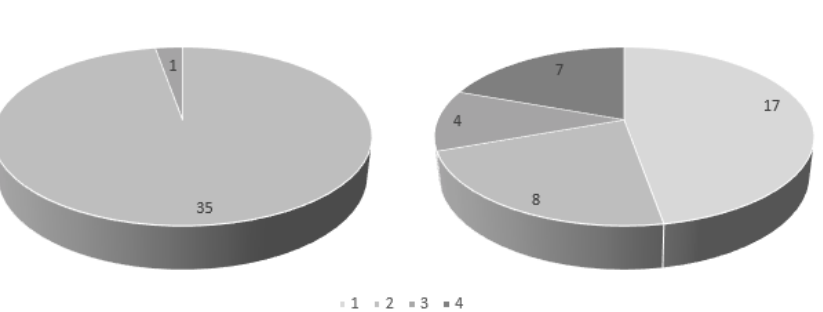
Figure 1. Comparison of the results of the qualitative and quantitative risk assessment of the managed substances.